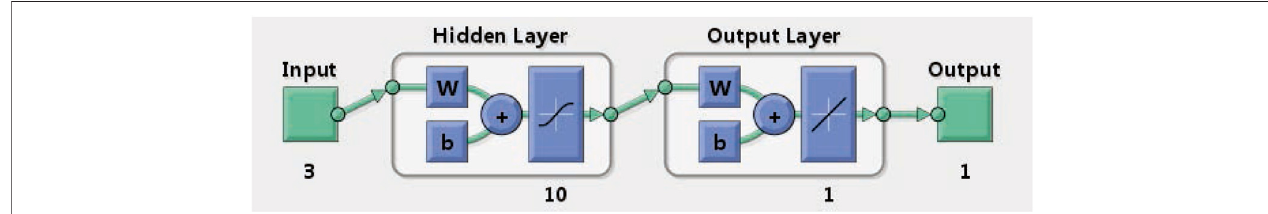
FIGURE 6 | Feedback architecture for the ANN model.